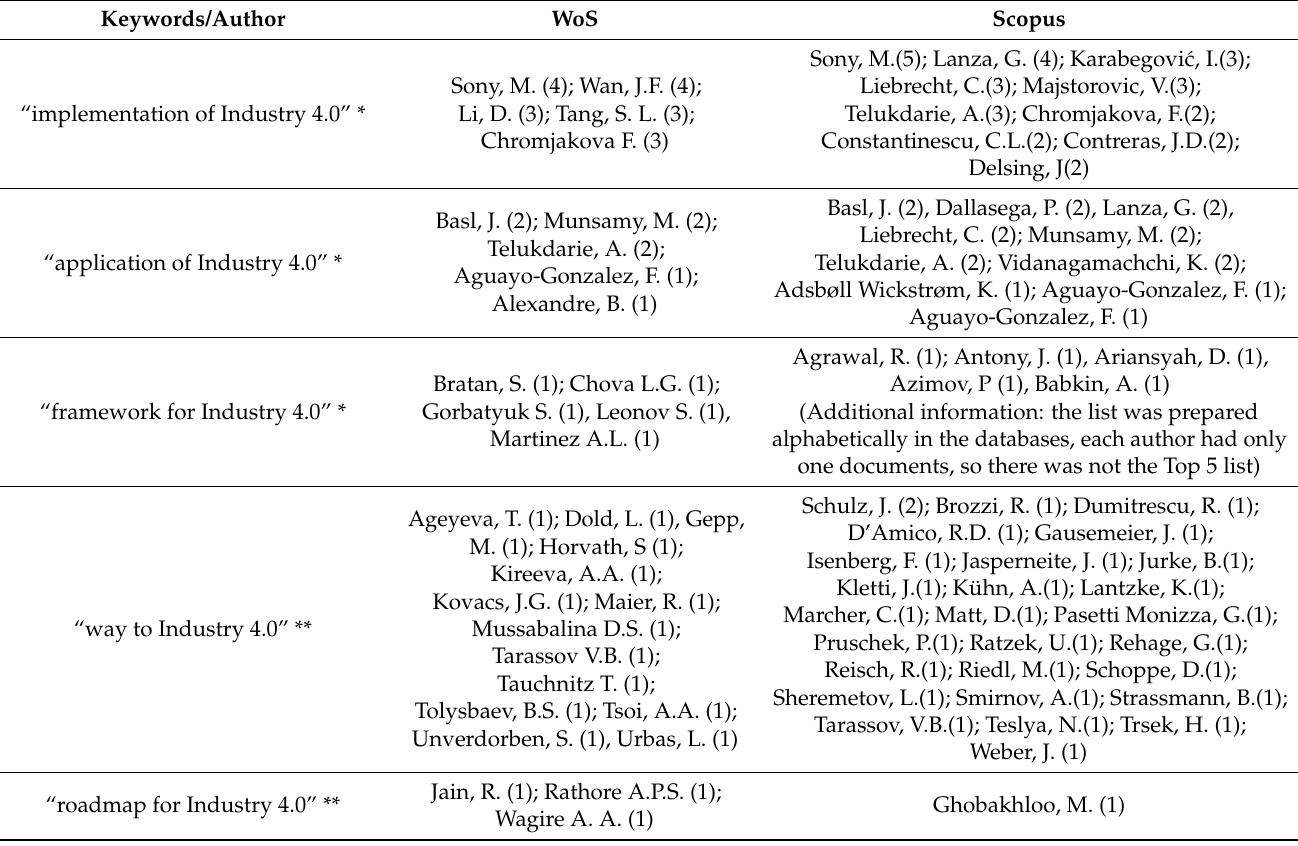
Table 4. Results of own literature review in the field: author of publication.